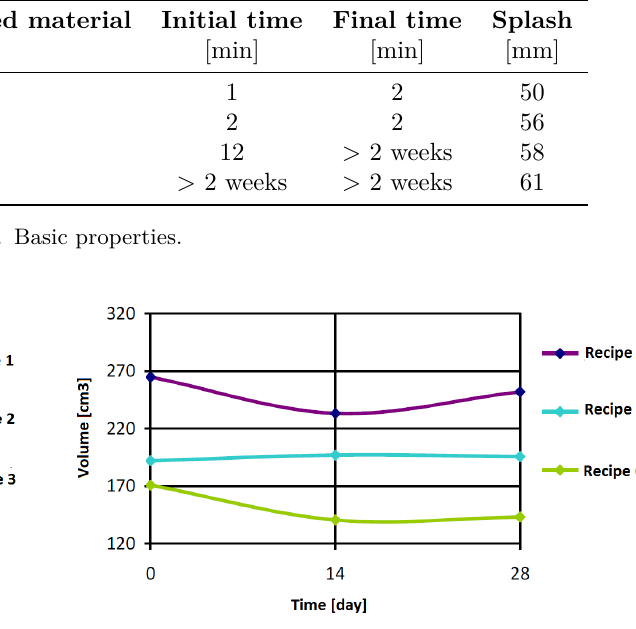
Figure 6. Volume changes over time – recycled plaster boards [8].